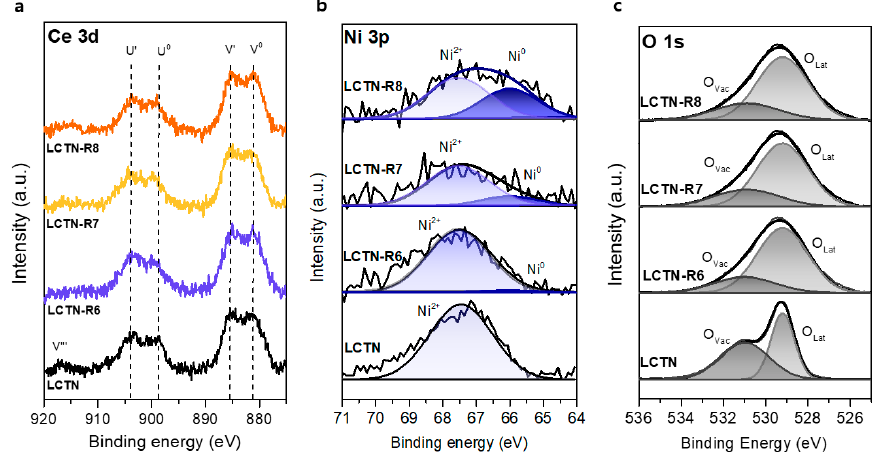
Figure 4. XPS spectra of LCTN, LCTN-R6, LCTN-R7, and LCTN-R8: ( a ) Ni 3p, ( b ) O 1s, and ( c ) Ce 3d.